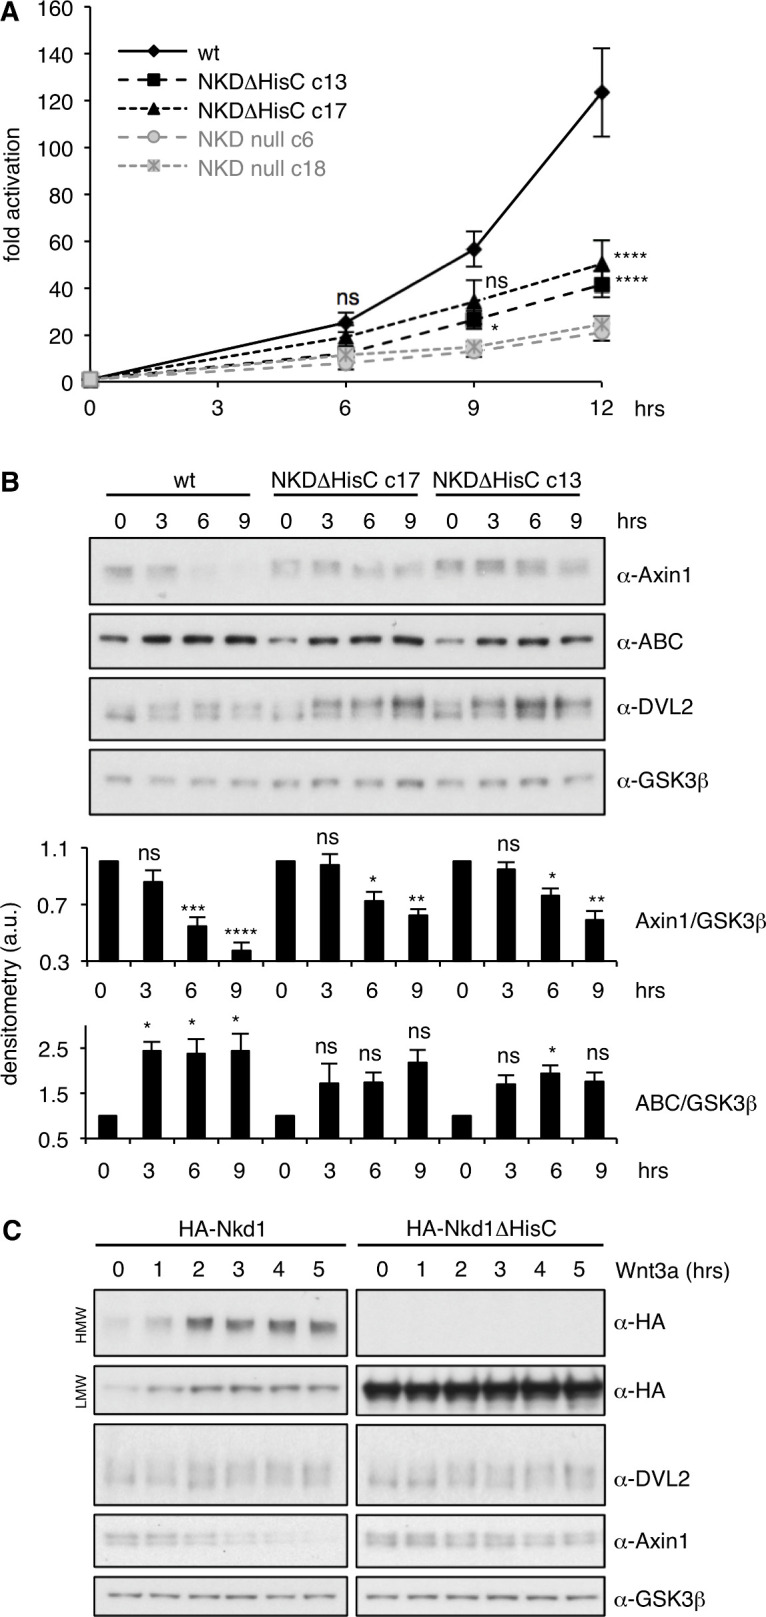
NKD is required for sustained Wnt signaling.(A) SuperTOP assays in HEK293T cells, monitoring the signaling response of NKDΔHisC, NKD null-mutant or control cells after 6 hr of Wnt3a stimulation (two independently isolated lines each, see also Figure 5—figure supplement 1); error bars, SEM of > 3 independent experiments; two-way ANOVA with multiple comparisons (for c13 and c17; see Figure 5—figure supplement 2 for null lines); *p < 0.05, ****p < 0.0001. (B) Representative western blots monitoring expression levels of endogenous proteins in two independent NKDΔHisC lines following 0–9 hr of Wnt stimulation (as indicated), quantified by densitometry of >3 independent experiments relative to GSK3β as internal control (a.u., arbitrary units); error bars, SEM of > 3 independent experiments; two-way ANOVA with multiple comparisons; ∗p < 0.05, ∗∗p < 0.01,∗∗∗p < 0.001, ∗∗∗∗p < 0.0001, ns = not significant. For the corresponding analysis of NKD null cell lines, see Figure 5—figure supplement 2. (C) Western blots monitoring the effects of overexpressed wt or ΔHisC HA-Nkd1 on the levels of endogenous proteins (indicated on the right; GSK3β, internal control) after 0–5 hr of Wnt stimulation.Figure 5—source data 1.Oligonucleotides used for CRISPR engineering of HEK293T cells and confirmation of lesions.